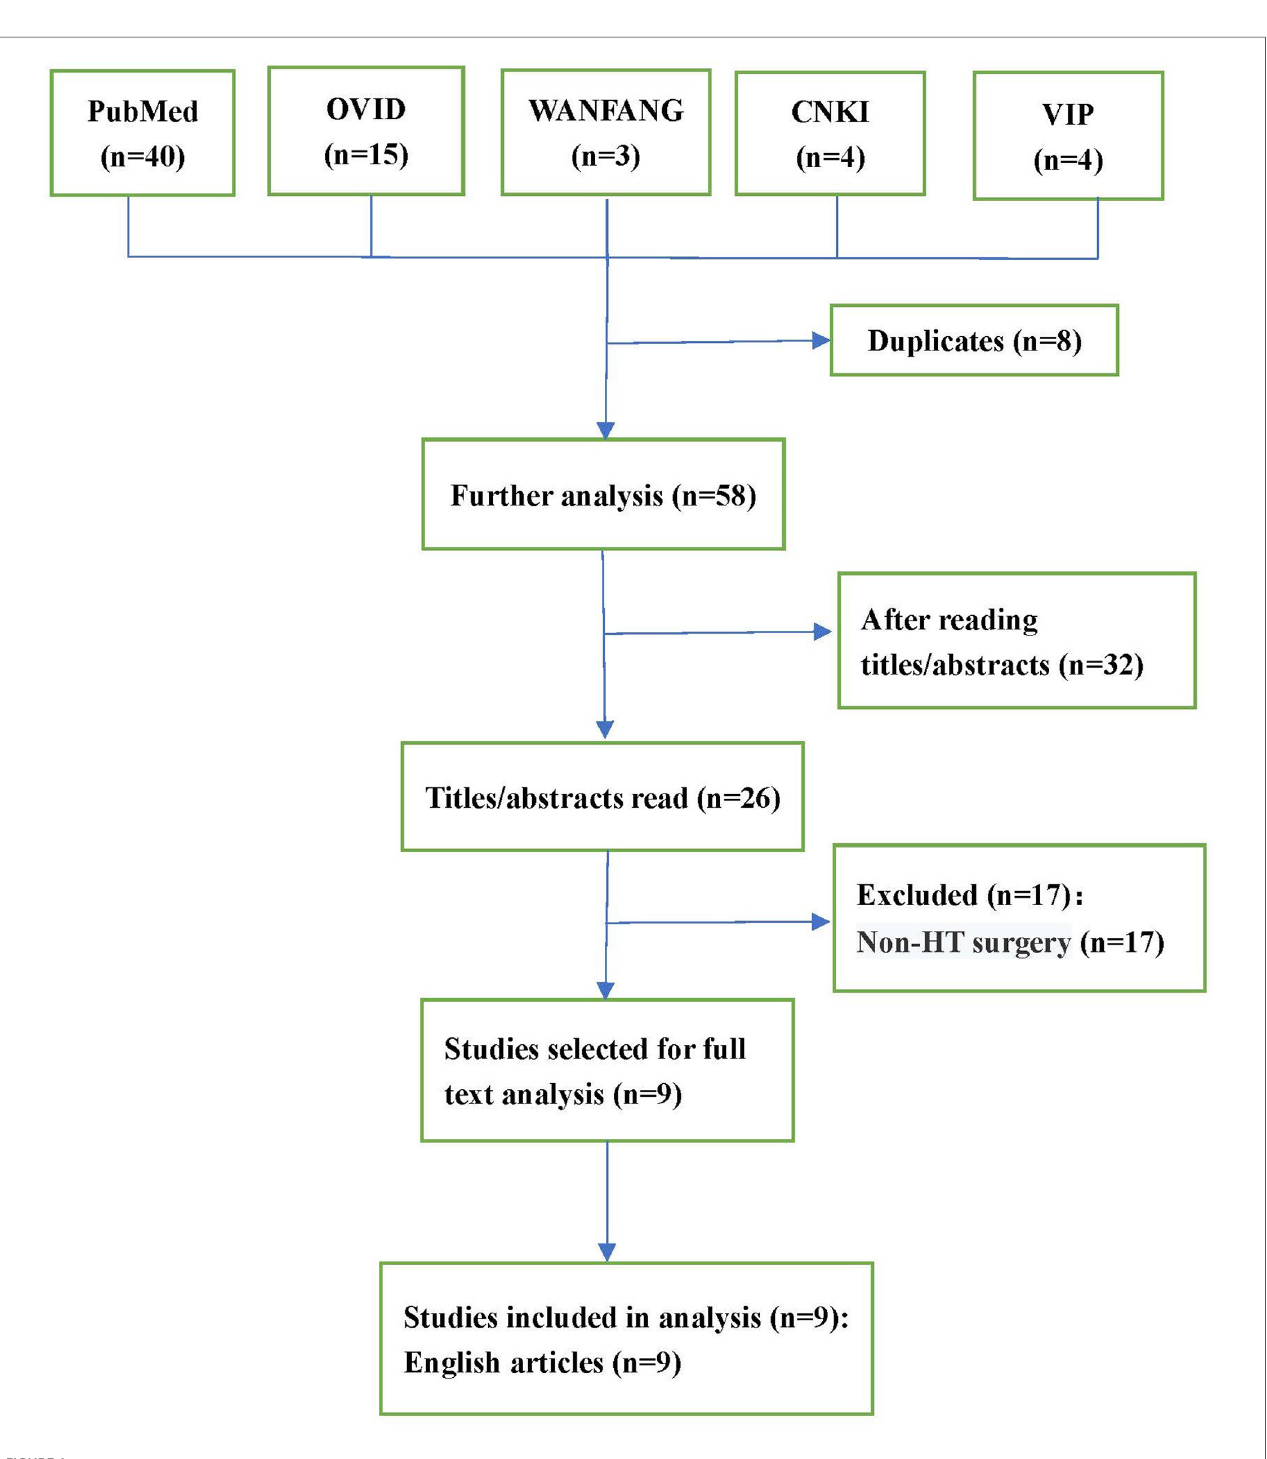
FIGURE 1 Flow diagram of study